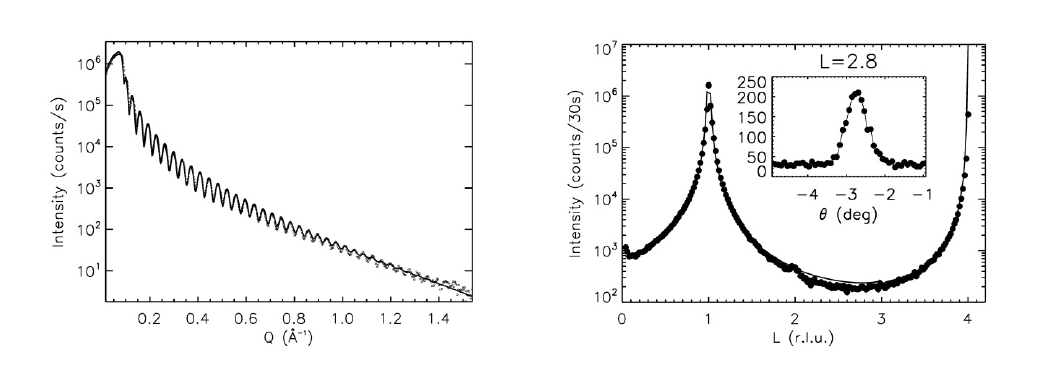
Figure 2: Left: X-ray reflectivity data (open symbols) and fit (solid line) of an approximately 15nm thin Ir film on a Al O (0001) substrate using Mo K α radiation. Right: (1,0) CTR of an Ir(111) single crystal 2 3 obtained in air (filled circles) and theoretical fit (solid line) (Vlieg, 2000). Inset: Rocking scan at L=2.8. A simulation of the experimental intensity variation with diffraction index is shown as well (solid curve). The inset shows a rocking curve close to the minimum of the CTR at L=2.8 and indicates that the diffraction signal from the surface is significantly higher than the